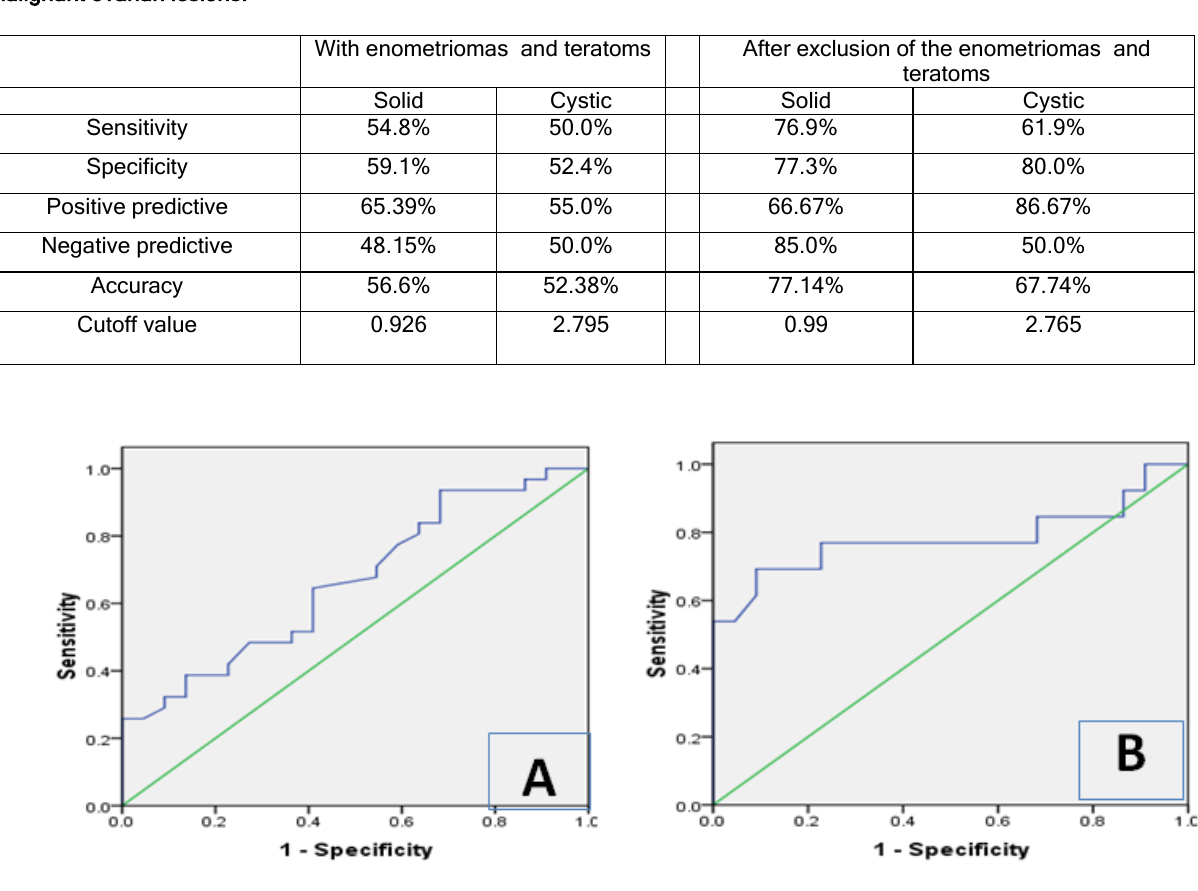
Figure (1): A: ROC comparative diagnostic values of quantitative ADC value parameter of the solid component for discriminating between benign and malignant ovarian lesions, B: the same curve in A after teratomas and endometriomas were